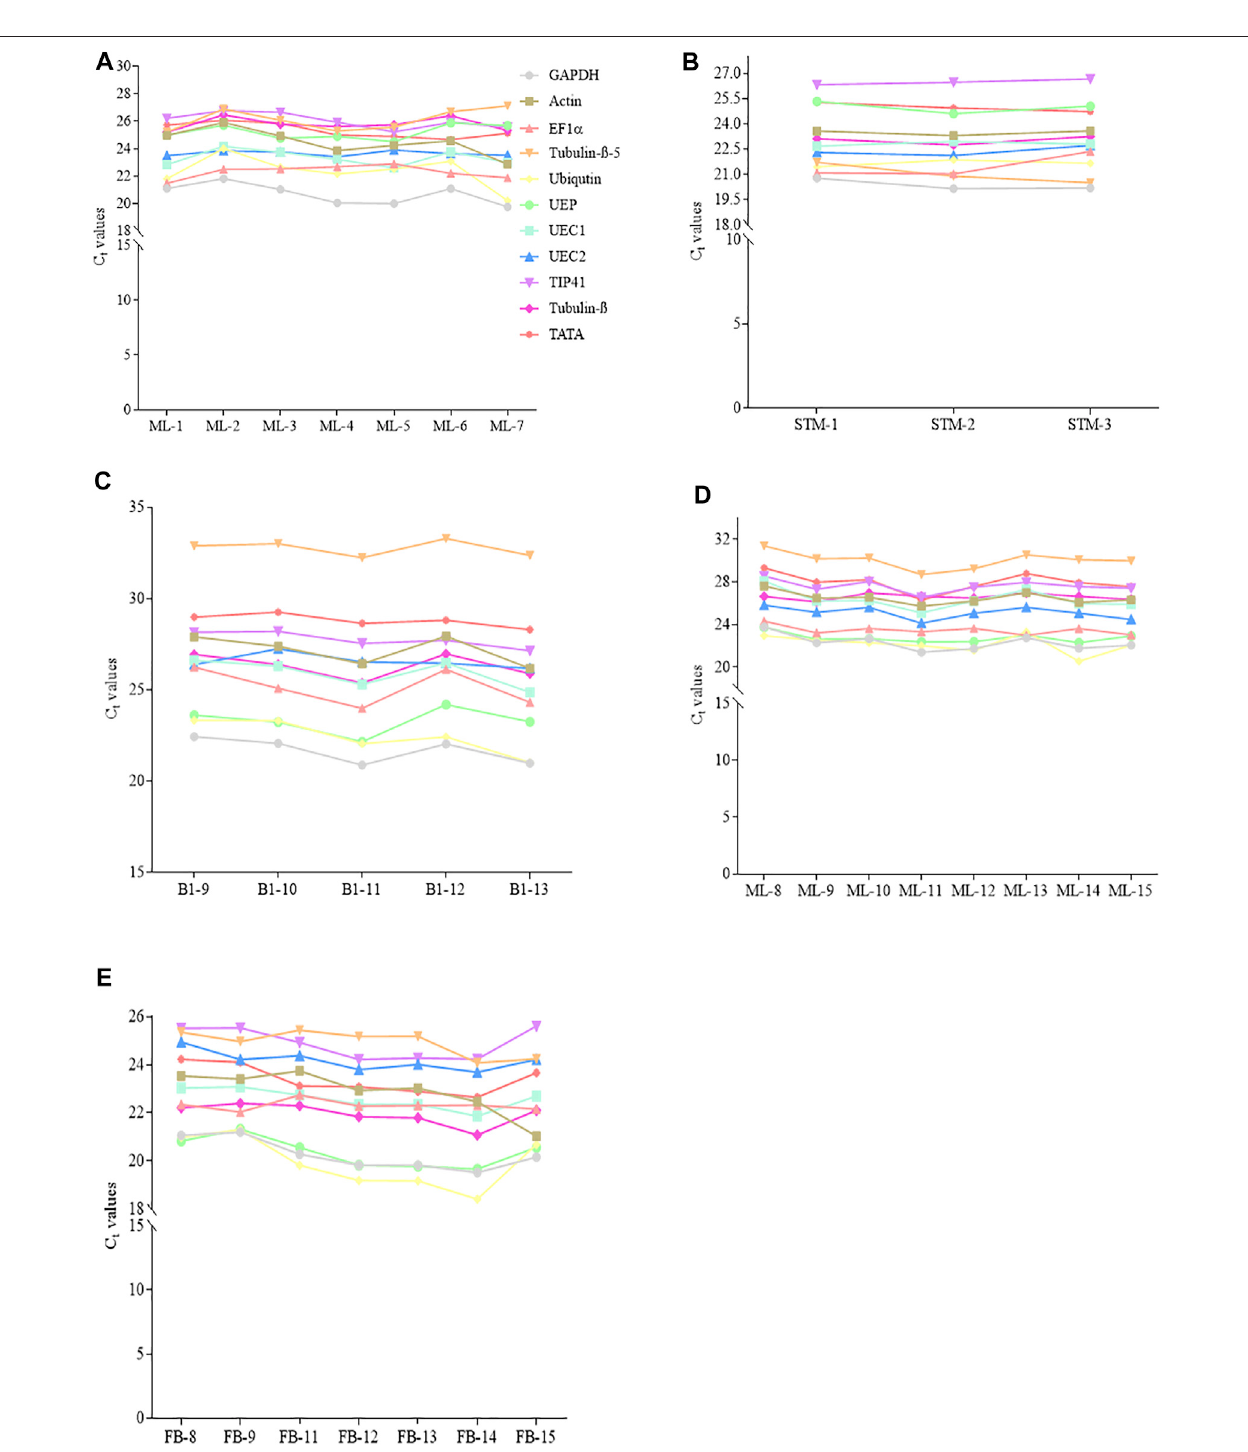
FIGURE 2 | Threshold cycle (C t ) of the 11 candidate reference genes in young and adult R. delavayi . (A) Young matured leaves (ML) (sampled at 9/22/2017, 10/8/ 2017,11/8/2017,12/8/2017,1/8/2018,1/23/2018,and2/8/2018denotedML1,ML2,ML3ML4,ML5,ML6,andML7,respectively). (B) Stemtipssampledfromyoung plant (at 9/22/2017, 10/8/2017, and 11/8/2017 denoted STM-1, STM-2, and STM-3, respectively). (C) Drought stress samples (sampled at 9, 10, 11, 12, and 13 days after droughtstress(DS)conditiondenotedB1-9,B1-10,B1-11,B1-12,andB1-13,respectively). (D) AdultML(sampled at9/22/2017,10/8/2017,12/8/2017,1/ 8/2018,1/23/2018,2/8/2018,and2/26/2018denotedML8,ML9,ML11,ML12,ML13,ML14,andML15,respectively). (E) Flowerbud(FB)(sampledat9/22/2017,10/ 8/2017, 12/8/2017, 1/8/2018, 1/23/2018, 2/8/2018, and 2/26/2018 denoted FB8, FB9, FB11, FB12, FB13, FB14, and FB15, respectively).